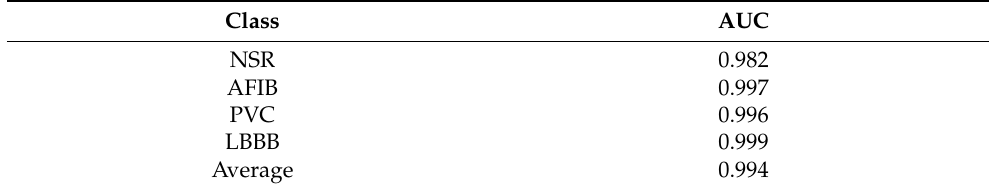
Table 4. AUCs of the algorithm.